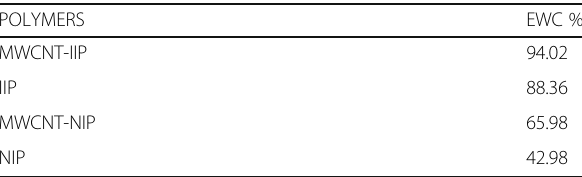
Table 1 EWC% of Cd(II) ion binding on MWCNT-IIP, IIP, MWCNT-NIP and